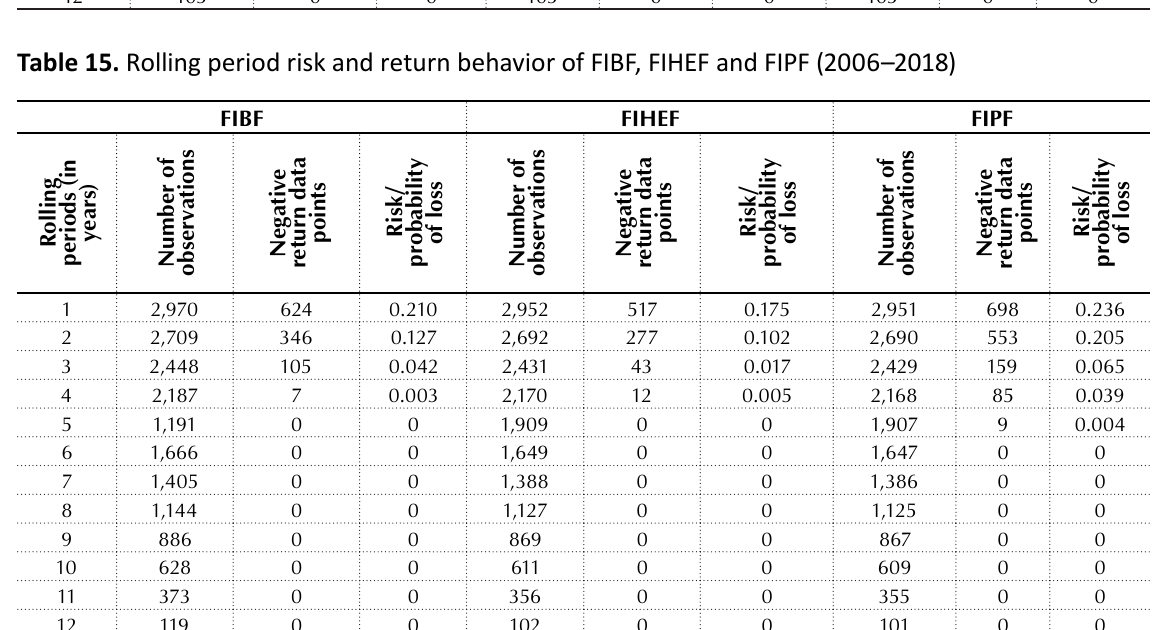
Table 16. Rolling period risk and return behavior of FIPPF, FISCF and DSPEHF (2006–2018) FIPPF FISCF DSPEHF